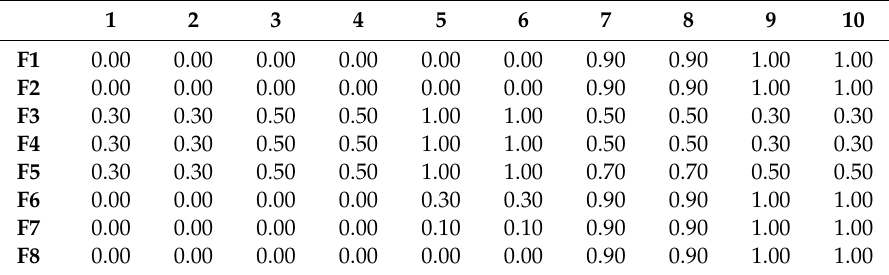
Table 9. Expert #1 favorable evidence degree versus VMEA